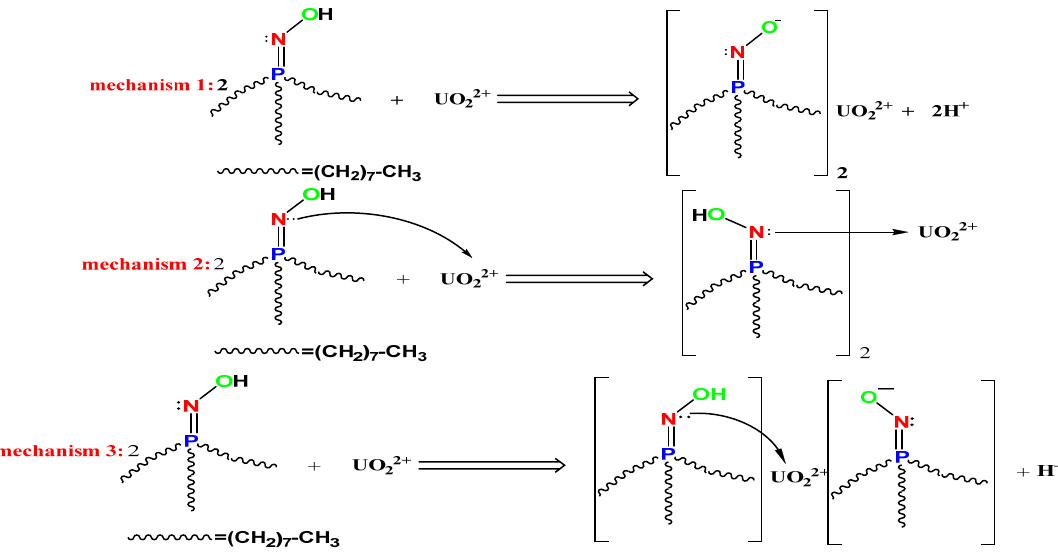
Scheme 5. Proposed mechanisms of UO 22+ ion extraction by HTIP chelating ligand.